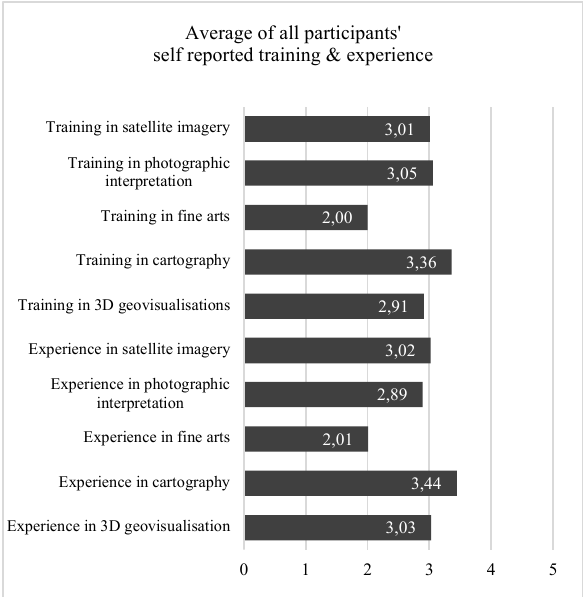
Figure 3. Participants’ self-reported training and experience in relevant domains (averaged for all participants). In the horizontal axis, 0 means no training/no experience , and 5 means highly trained/very experienced